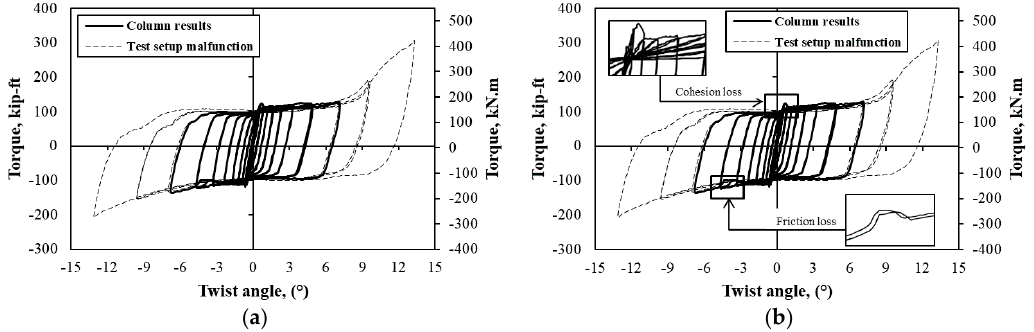
Figure 5. Torque-twist angle of a HC-FCS column under pure torsion: ( a ) with the idealized curve, and ( b ) with focus on cohesion and friction losses.